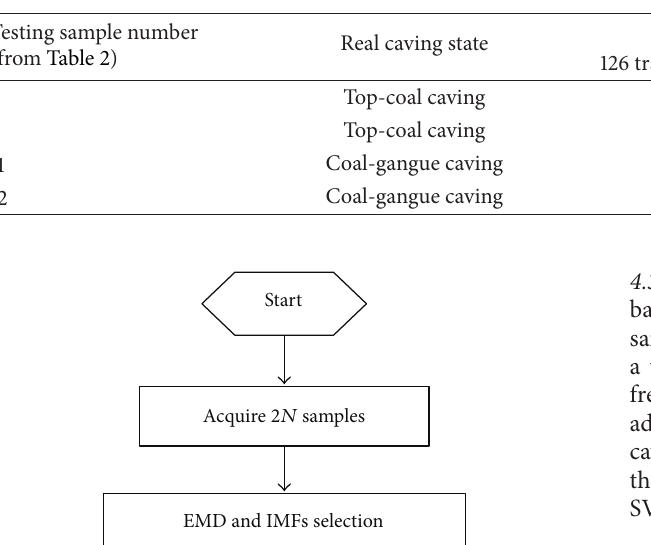
respectively. The 2𝑁 samples are divided into two subsets, the training samples sets and the testing samples